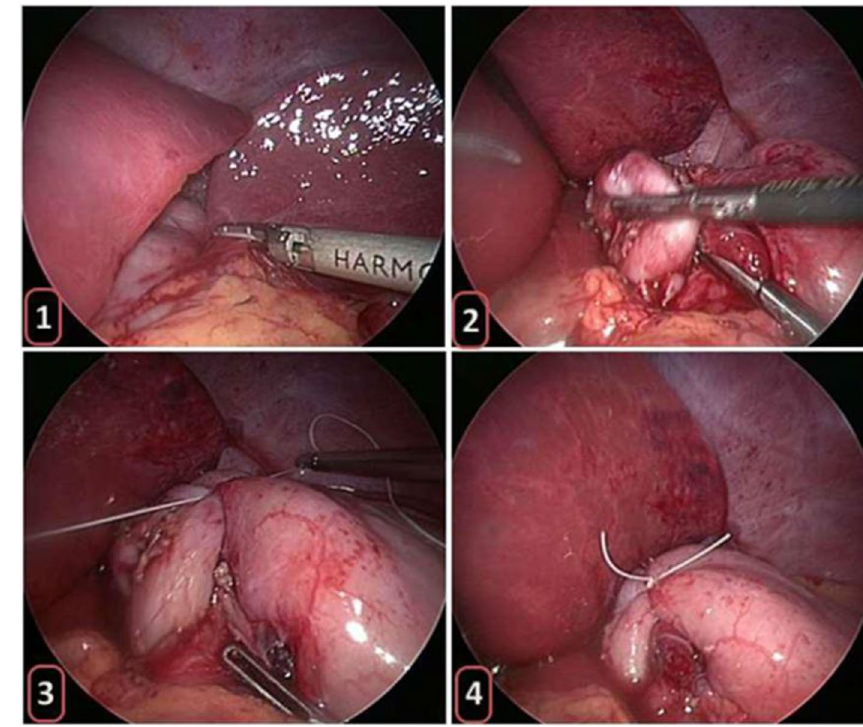
Fig. 2 1 Division of the short gastric vessels. 2 Pulling the fundus behind the esophagus. 3 First suture of the wrap. 4 Wrap